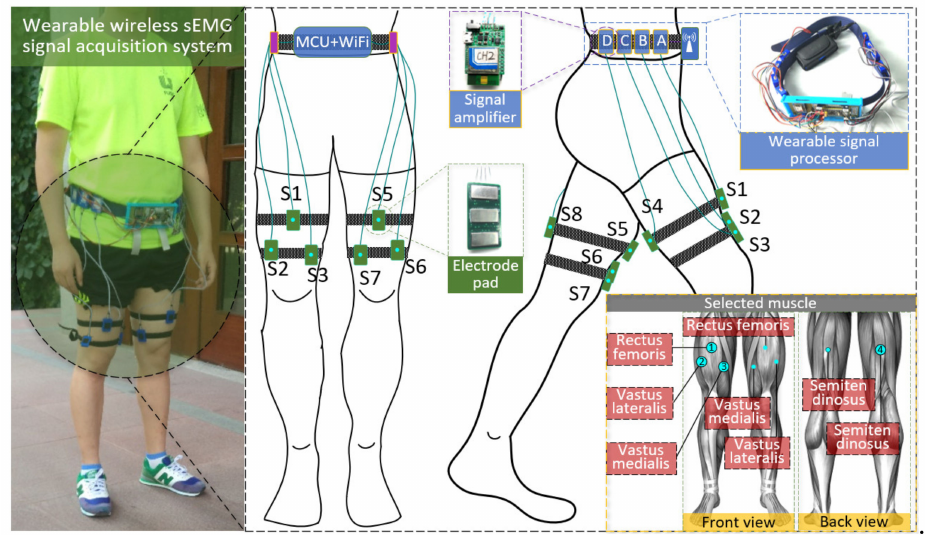
Figure 1. Lower-limb wearable surface electromyography acquisition system.